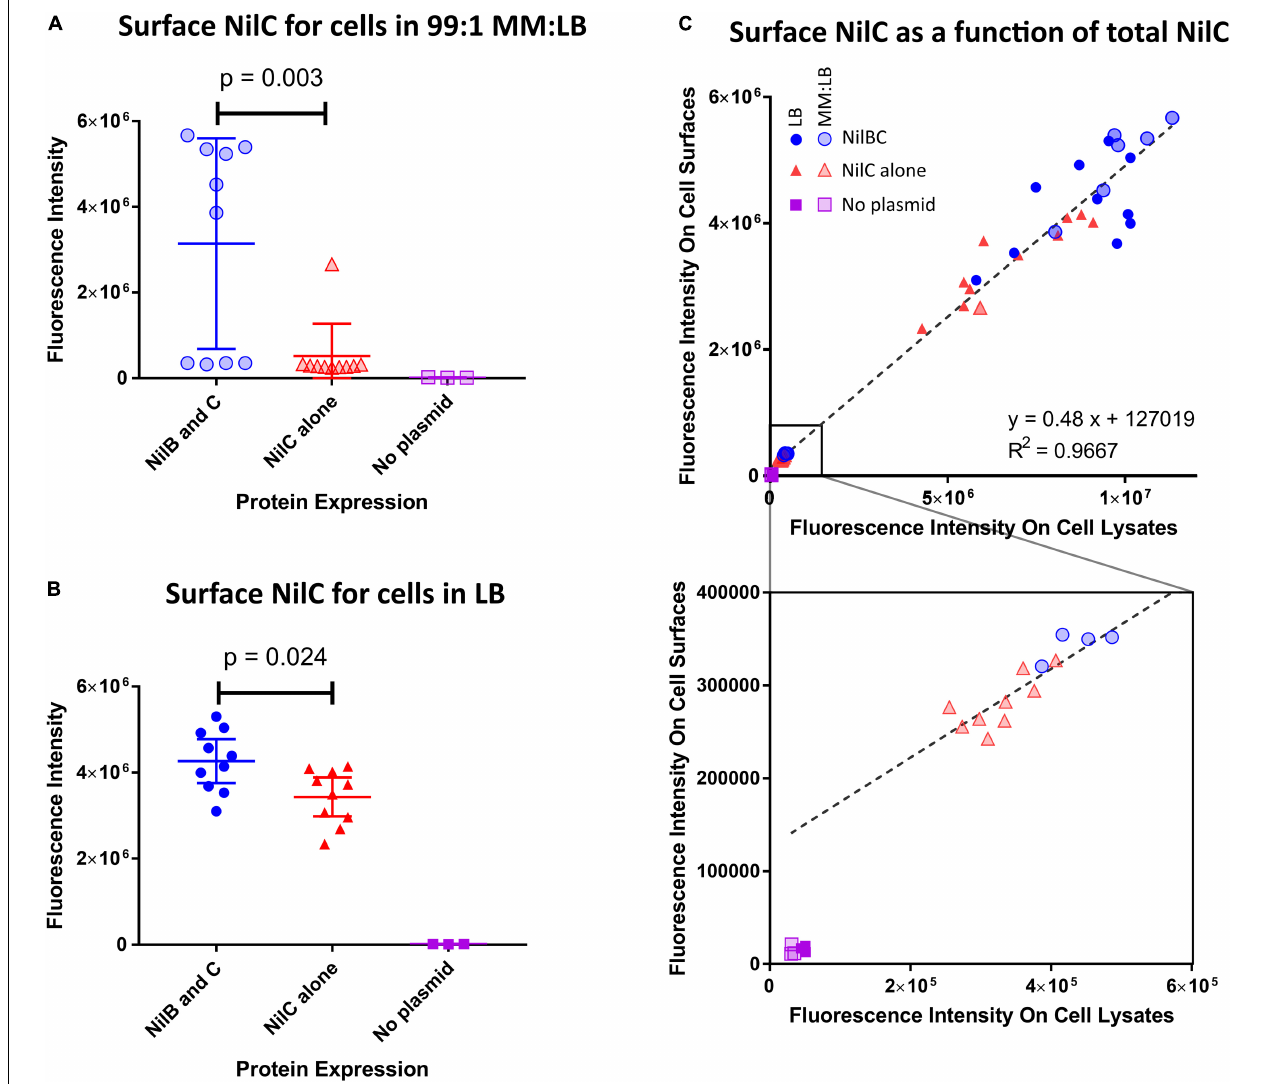
FIGURE 1 | NilB positively influences the amount of NilC present on the surface of E. coli when co-expressed. E. coli BL21 DE3 C43 was transformed with pET-Duet-1 plasmids carrying nilC alone (red triangles) or both nilC and nilB (blue circles) under control of the inducible T7 polymerase promoter. A no-plasmid control (purple squares) was included to account for a potential cross-reacting signal. Surface exposure of NilC was quantified by immunofluorescence with anti-NilC antibody dot blotting of cells grown in LB [ (B,C) solid symbols], or MM:LB [ (A,C) transparent symbols]. p -values were determined via one-way ANOVA with Tukey’s multiple comparison. Total cellular levels of NilC were quantified by immunoblotting whole cell lysates from the same samples and surface NilC as a function of total cellular NilC is shown in (C). A linear regression of data from both media conditions revealed that total NilC expression was a strong predictor of surface exposure of NilC (R-squared = 0.9667). The bottom graph provides an expanded view of the region of the top graph indicated with a square.